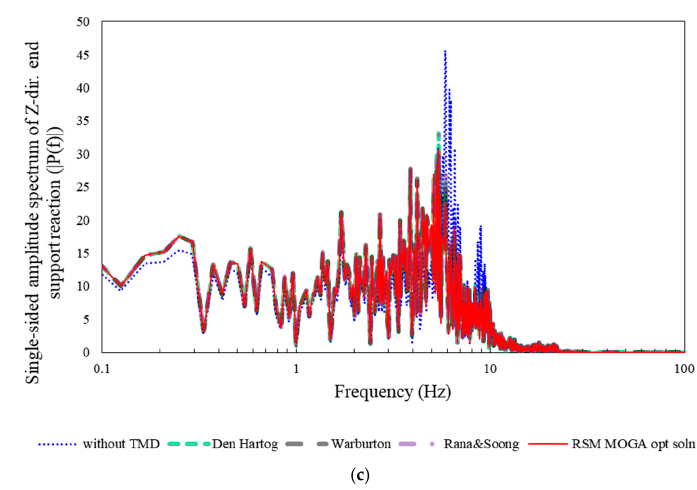
Figure 14. Comparison of the FFT frequency responses of the reaction forces at the lowest support of the piping system: ( a ) X direction FFT spectrum; ( b ) Y direction FFT spectrum; ( c ) Z direction FFT spectrum.